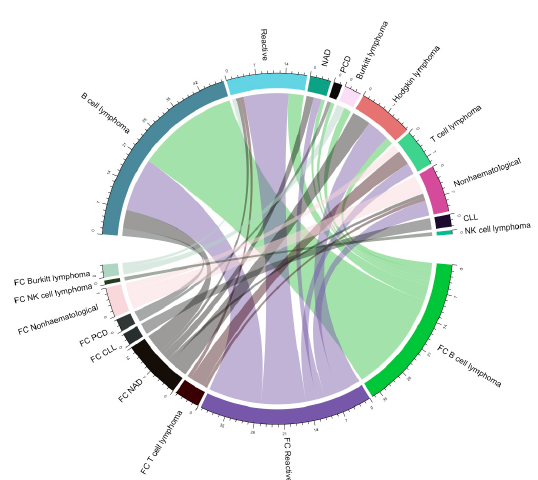
Figure 2. Chord diagram representing the agreement between FNA FC diagnoses (represented with FNA FC diagnoses with FC before their name) and histological diagnoses (represented with histological diagnoses). NAD: no abnormalities detected; CLL: chronic lymphocytic leukemia; PCD: plasma cell dyscrasia; NK cell lymphoma: natural killer cell lymphoma.